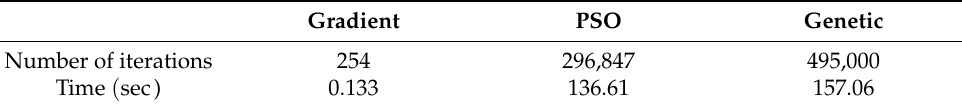
Table 8. The number of iterations and elapsed time according to optimization